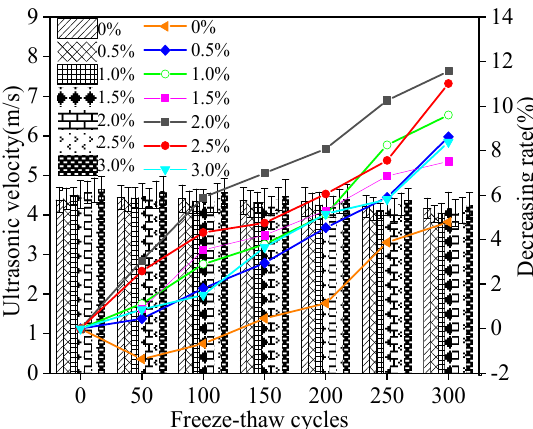
Figure 11. The ultrasonic velocity of MPC-RPC during NaCl F-T cycles.